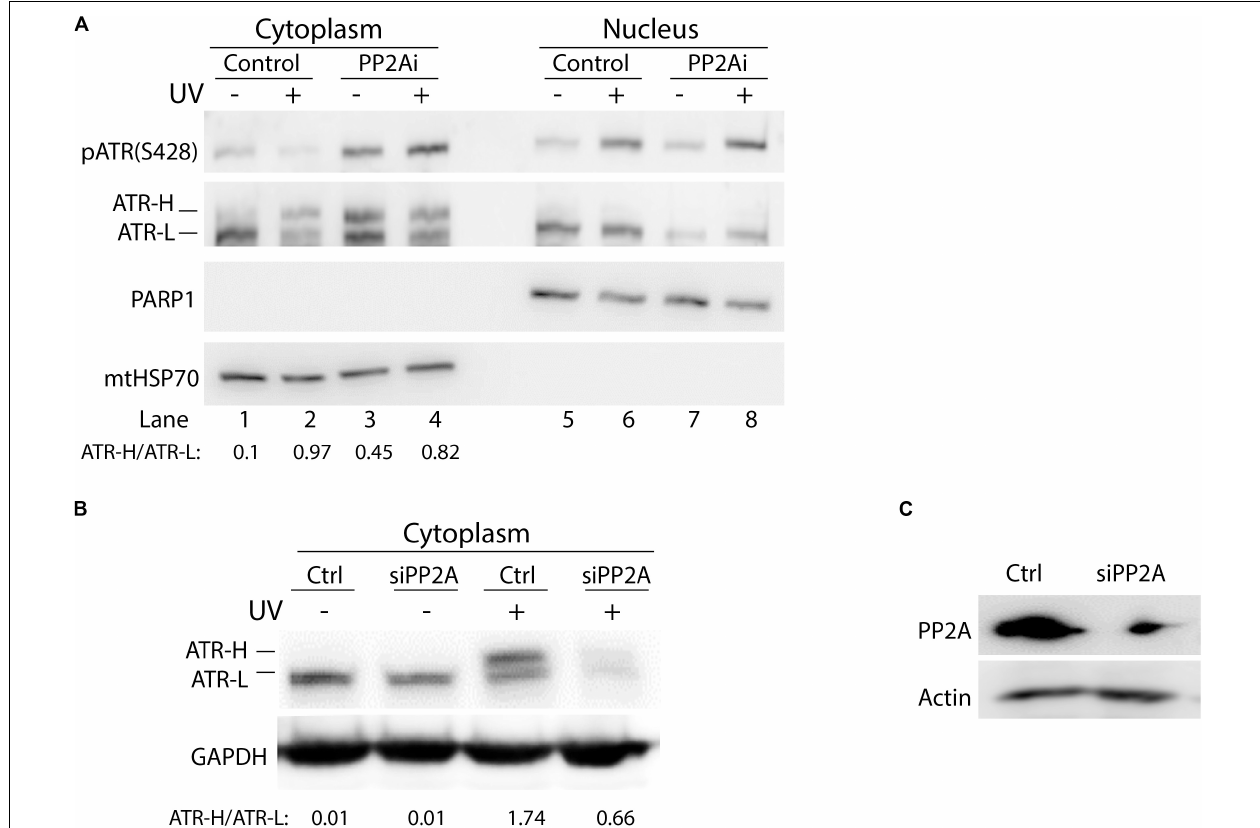
FIGURE 3 | Protein phosphatase 2A (PP2A) dephosphorylation of pATR changes ATR to the higher form (ATR-H). (A) UV irradiation of A549 cells at 40 J/m 2 increases the formation of ATR-H in the cytoplasm. Also, the ATR-H is not phosphorylated while the ATR-L band is phosphorylated in both the nucleus and the cytoplasm (cytoplasm to nucleus loading ratio = 3:1). The samples were analyzed on a 3–8% gradient gel. (B) A549 cells were pretreated with DMSO (Ctrl) or transfected with PP2A siRNAs, then UV-irradiated at 40 J/m 2 (–/+UV) followed by a 2 h recovery. The cytoplasmic fraction was analyzed by electrophoresis through a 3–8% gradient gel and WB to show the form of ATR in the cytoplasm. PP2A depletion reduces the levels of cytoplasmic ATR and the amount of ATR-H formed following UV treatment. (C) WB showing PP2A siRNA knockdown efficiency in A549